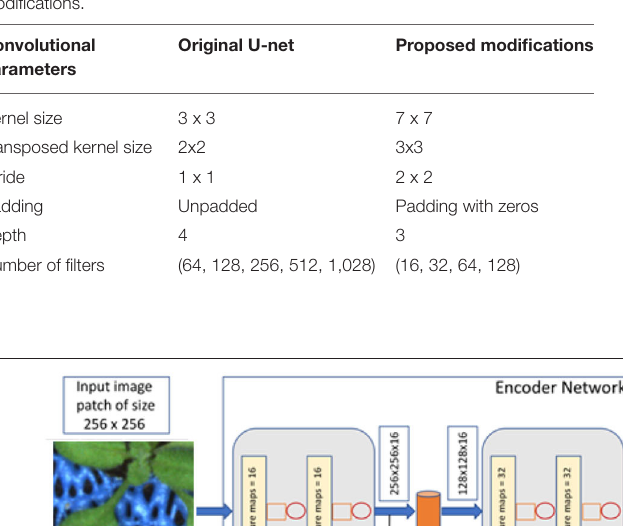
TABLE 1 | Convolutional parameters of the original U-net and proposed modifications.